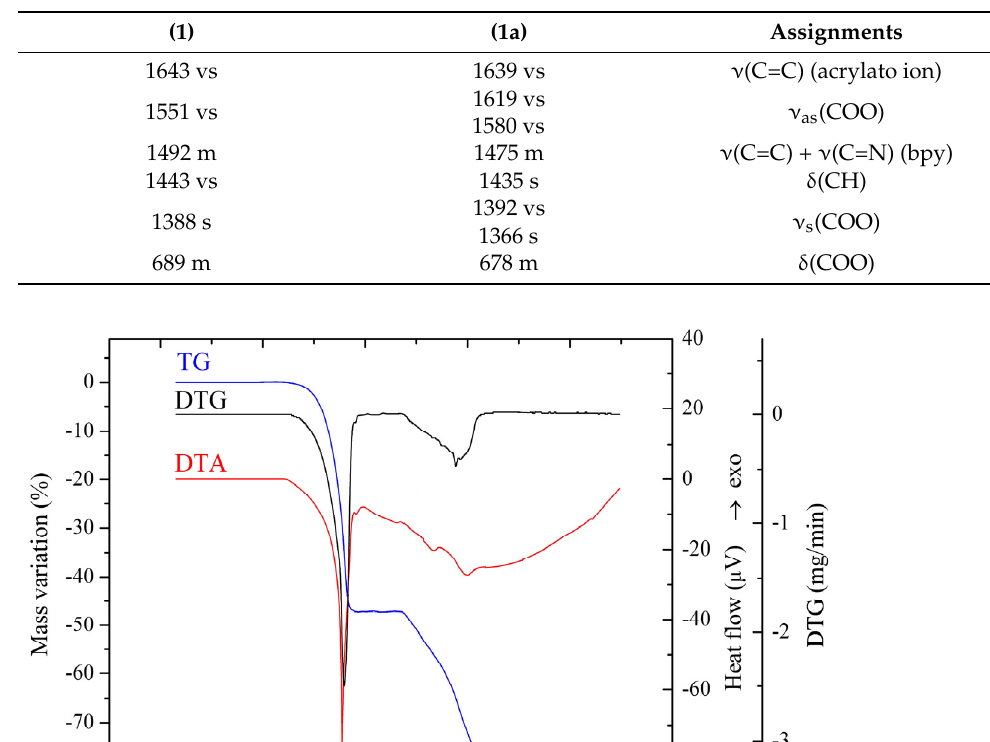
Table 2. Absorption maxima (cm − 1 ) for complexes ( 1 ) and ( 1a ).